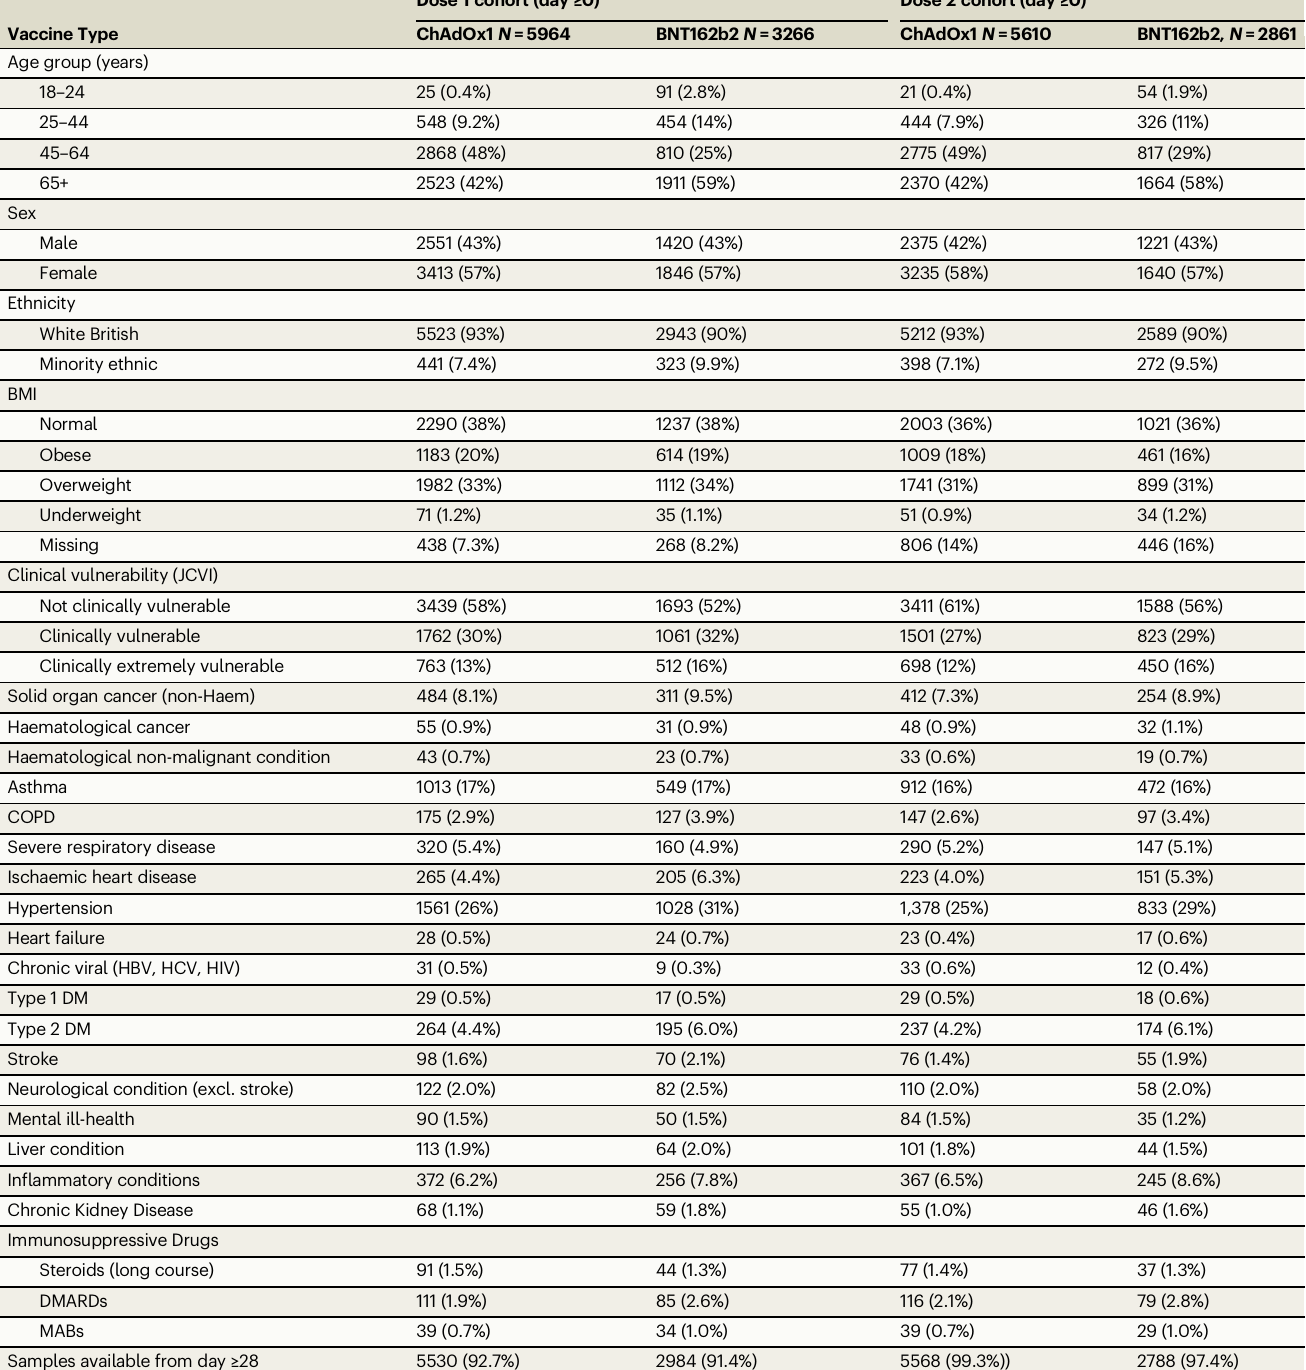
Table 1 | Demographic and clinical characteristics of individuals who were sampled following Dose 1 and Dose 2 of either ChAdOx1-S or BNT162b2